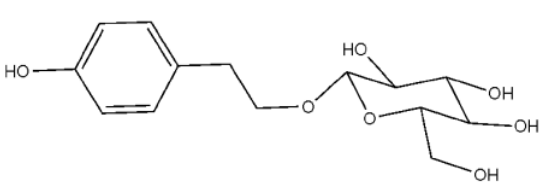
Figure 1. Structure of